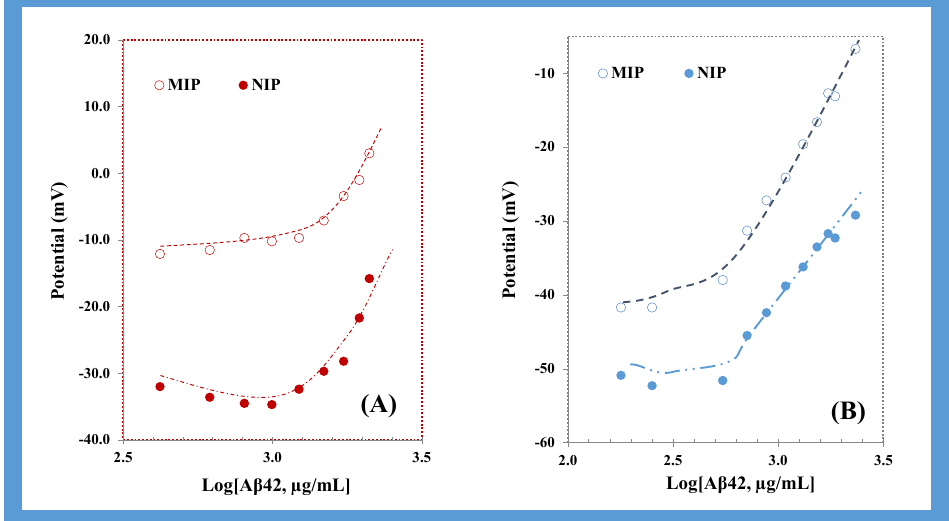
Figure 5. Calibration curve of the ISE − based sensors in MPOS buffer: ( A ) pH 6.0 and ( B ) pH 8.0. Overall, the best results in terms of the analytical performance were obtained for the membranes with MIP as an ionophore at pH 8.0. These conditions were used for further studies.